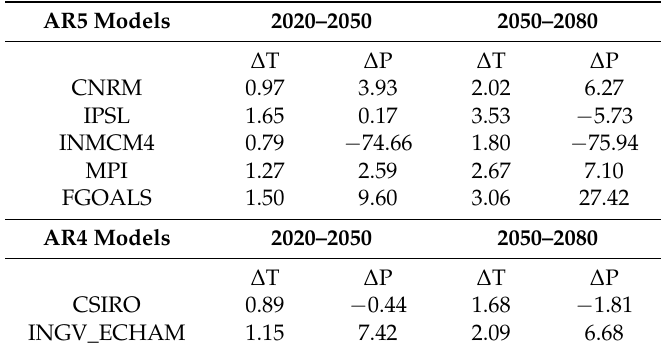
Table 3. Summary of projected mean annual temperature ( ∆ T) and precipitation ( ∆ P) in the Niger Delta by seven Global Climate Models